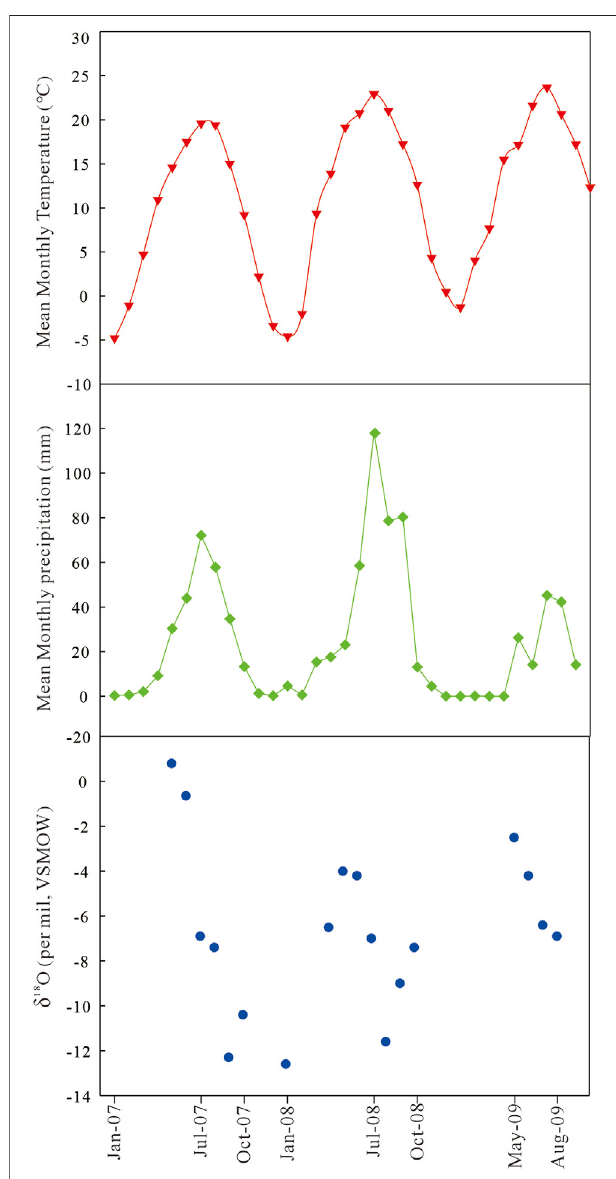
FIGURE 8 | Plots of mean monthly values of temperature, precipitation, and precipitation δ 18 O for the Xunhua Basin (modi fi ed from Hough et al.,